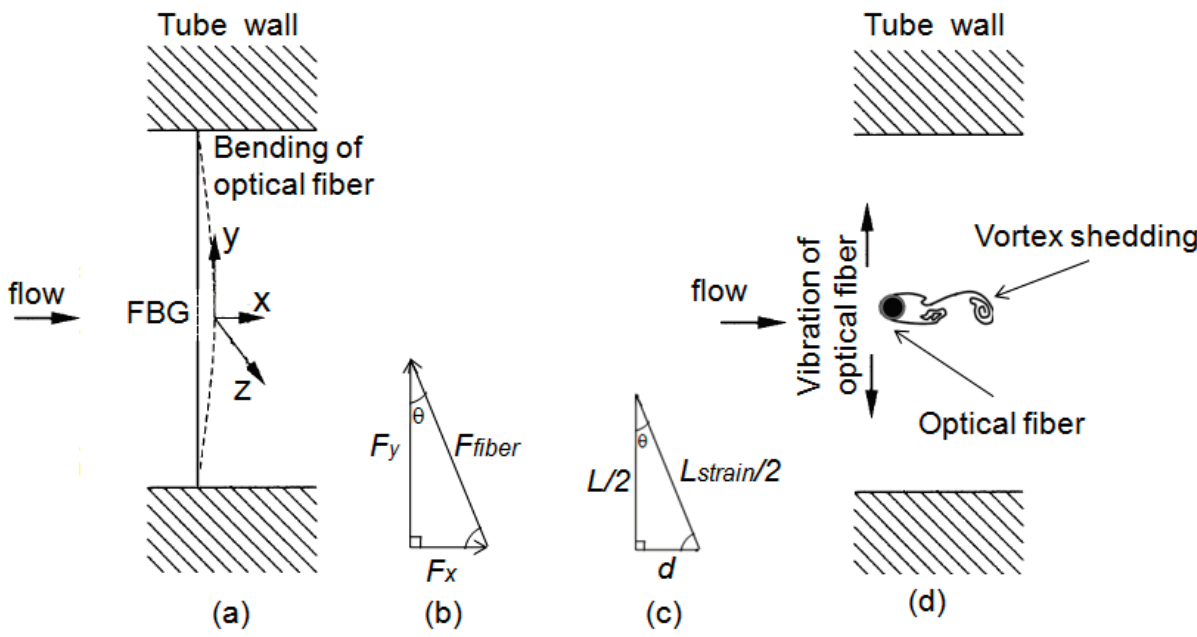
Figure 1. Schematic drawing of the forces that appear in the optical fiber inserted across a flow: ( a ) side view; ( b ) force diagram; ( c ) diagram showing the changes in dimension of the strained optical fiber; and ( d ) top view of the acting forces. FBG, fiber Bragg